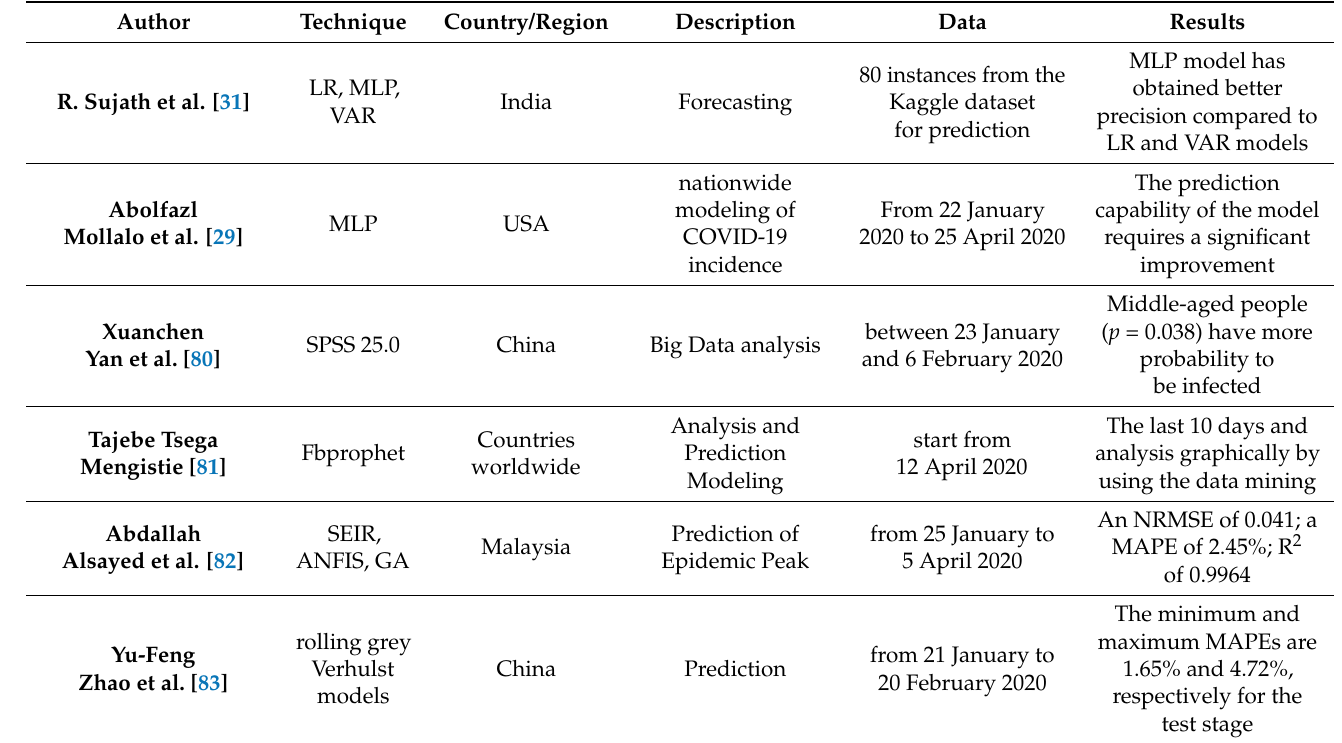
Table 2. Combination of statistical techniques with AI-based approaches to predict the COVID-19